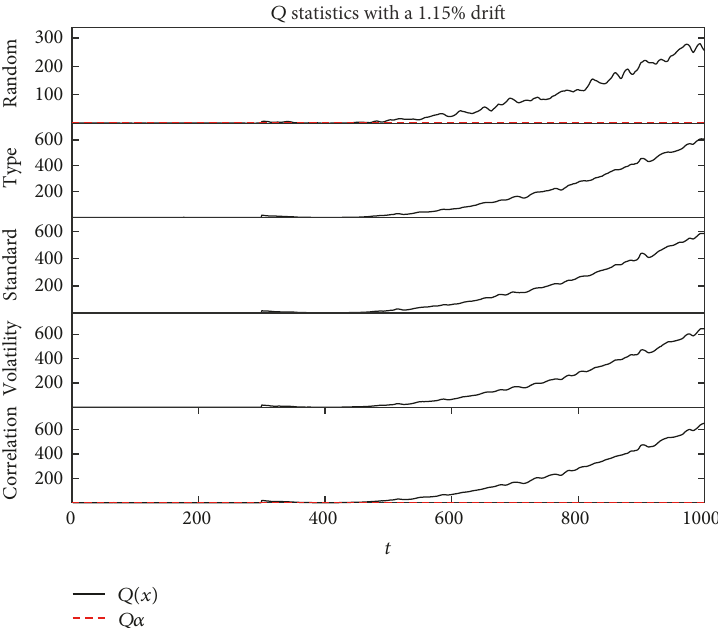
Figure 14: 𝑄 statistics with a larger drift in 5 PCA